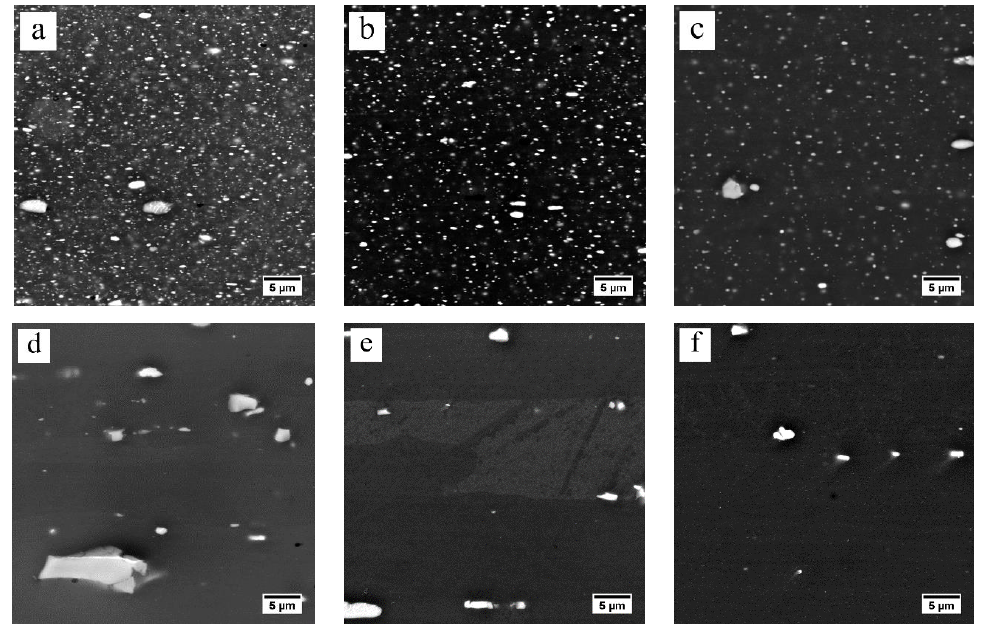
Figure 8. The SEM-BSE images of slow-heated samples quenched at ( a ) 300 °C, ( b ) 350 °C, ( c ) 400 °C, ( d ) 450 °C, ( e ) 475 °C and ( f ) 475 °C for 1 h.